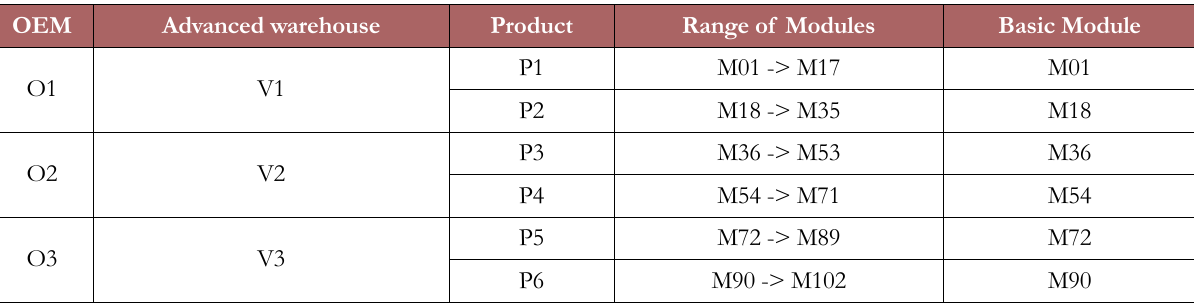
Table 3. Affectations of OEMs